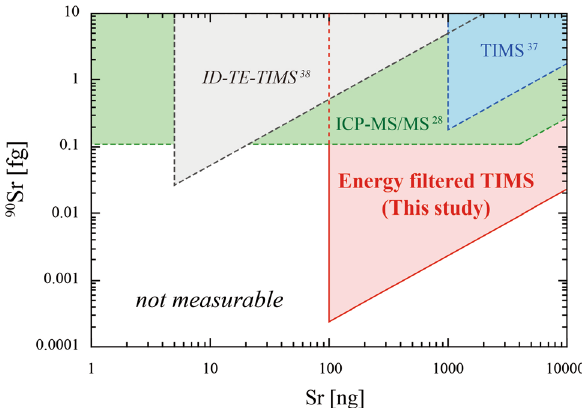
Figure 5. The capability of the mass spectrometric 90 Sr determination methods is demonstrated using the absolute amount of stable Sr and 90 Sr required for a single measurement. Samples within the shaded area are measured by the method. The lowest point of the shaded area corresponds to the detection limit of 90 Sr for